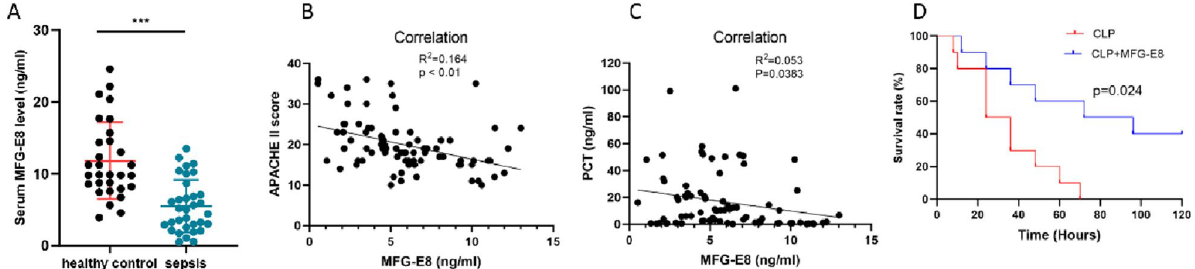
Figure 1. Serum MFG-E8 levels are decreased in patients with sepsis compared with healthy controls and are negatively correlated with disease severity. ( A ) Serum MFG-E8 levels in 100 septic patients and 30 normal individuals. Mean ± SEM, ***p < 0.001. ( B ) Correlation analysis of the Acute Physiology and Chronic Health Evaluation (APACHE) II score and serum MFG-E8 levels of septic patients. p = 0.0001. ( C ) Correlation analysis of procalcitonin (PCT) and serum MFG-E8 levels of septic patients. p = 0.0383. ( D ) MFG-E8 improves the survival in cecal ligation and puncture (CLP)-induced